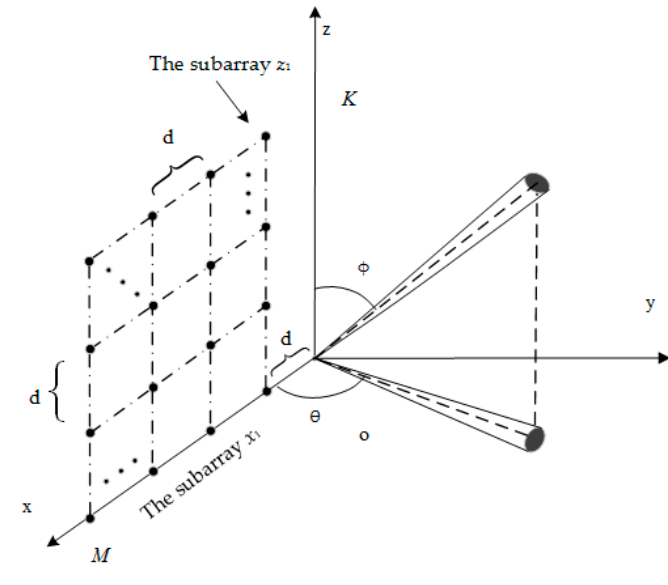
Figure 1. Uniform rectangular arrays configuration.